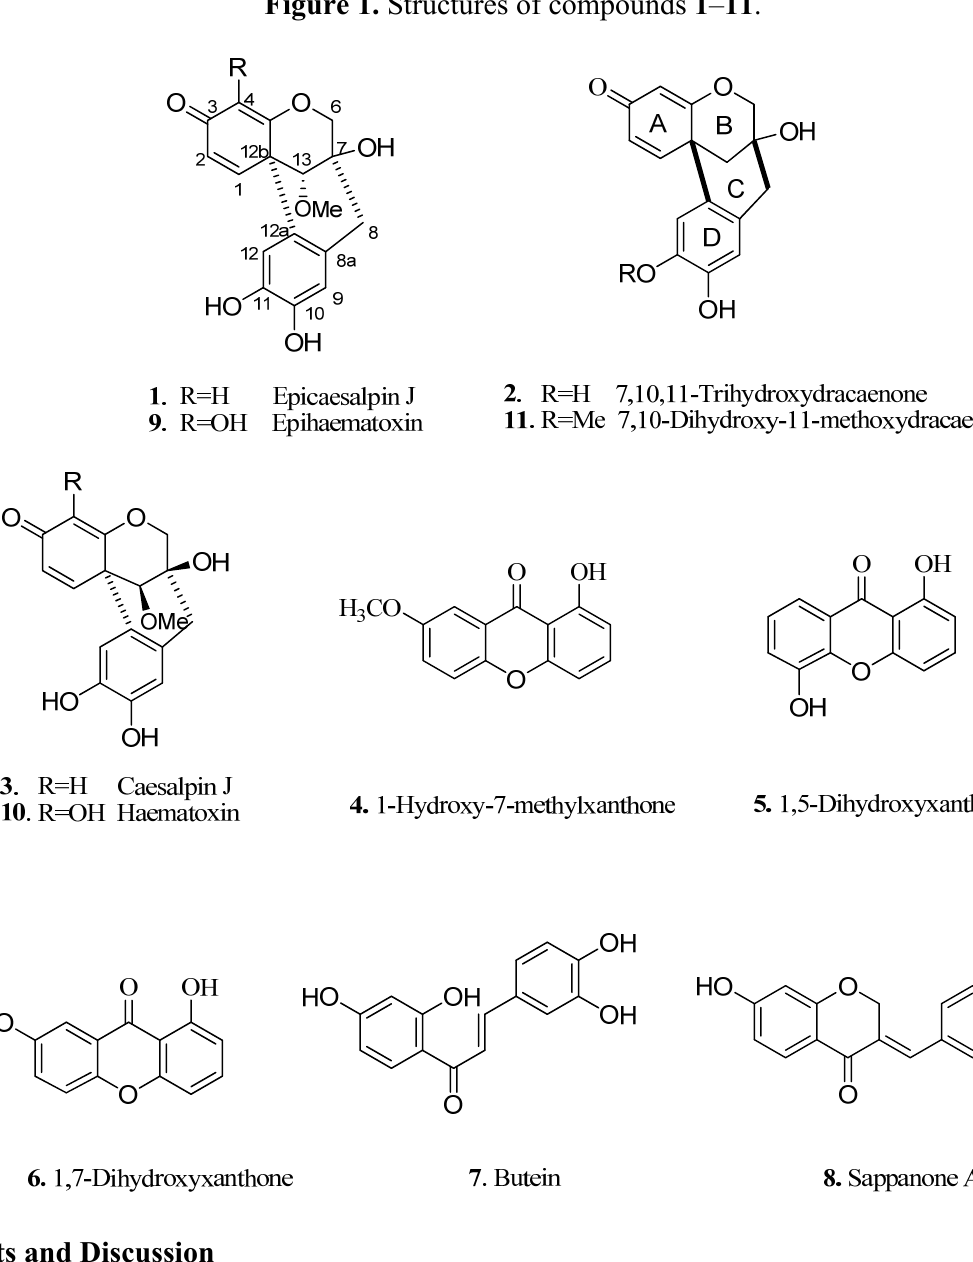
Figure 1. Structures of compounds 1 – 11